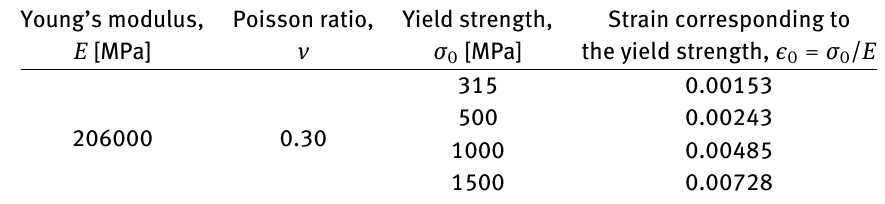
Table 2: Mechanical properties of the elastic-ideally plastic materials modelled numerically to determine the limit loads [12]. Young’s modulus, Poisson ratio, Yield strength, Strain corresponding to E [MPa]